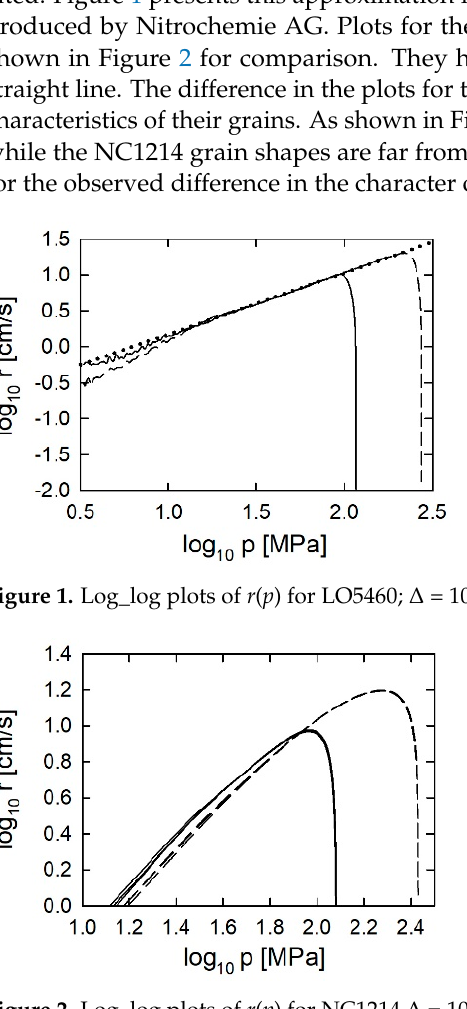
Figure 2. Log_log plots of r ( p ) for NC1214 ∆ = 100 kg/m 3 (solid line), 200 kg/m 3 (dashed line).